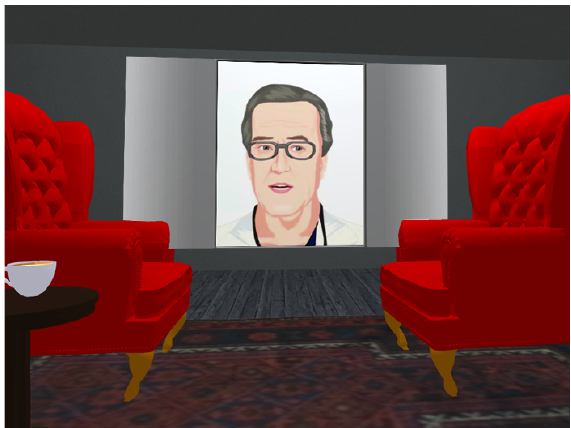
Figure 3. Still from Psychasthenia 2 website. Courtesy of the authors.